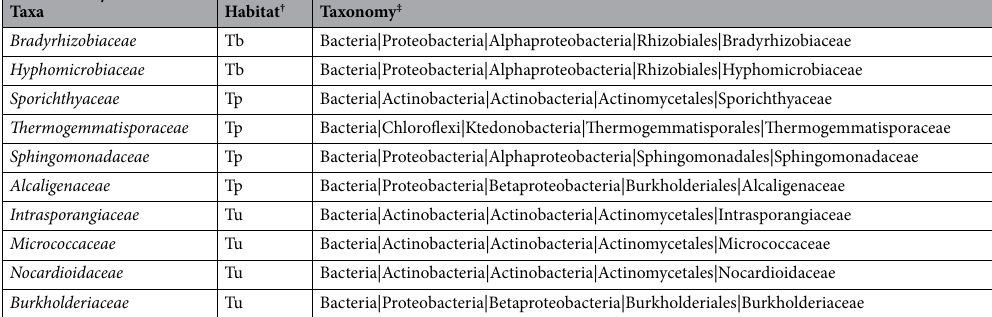
Supplementary Table S4). The bacteria at A site, thus are possibly more capable of utilizing glutamate for growth, while resident bacteria in the OSC are conceivably better furnished with stress response mechanisms critical in environmental adaptation and survival.